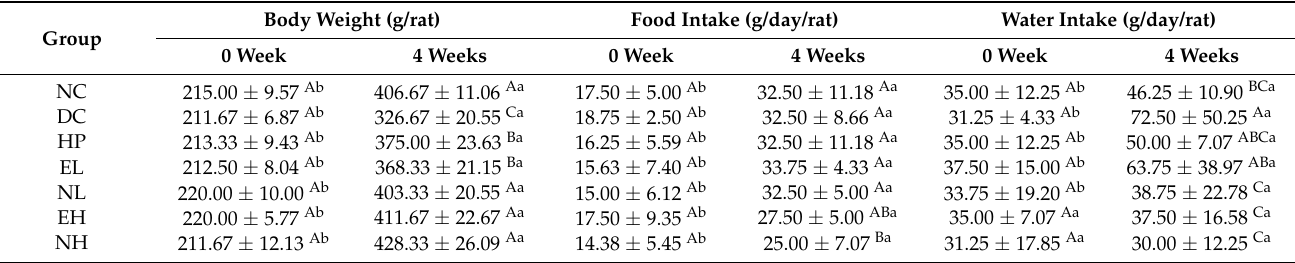
Table 8. Effects of C. osmophloeum leaf extract, nanoemulsion and hydrosol on body weight, food intake and water intake of rats on a high-fat diet that received streptozotocin injection for diabetes